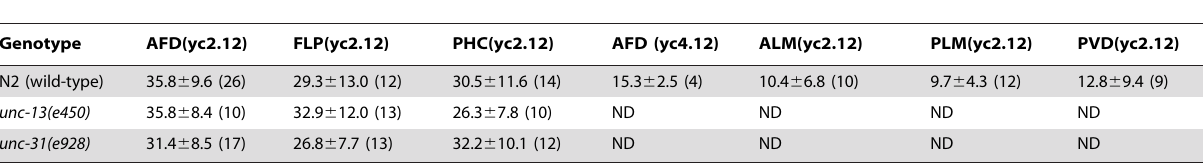
Table 2. YFP/CFP ratio change (calcium influx) after noxious heat stimuli in different sensory neurons.